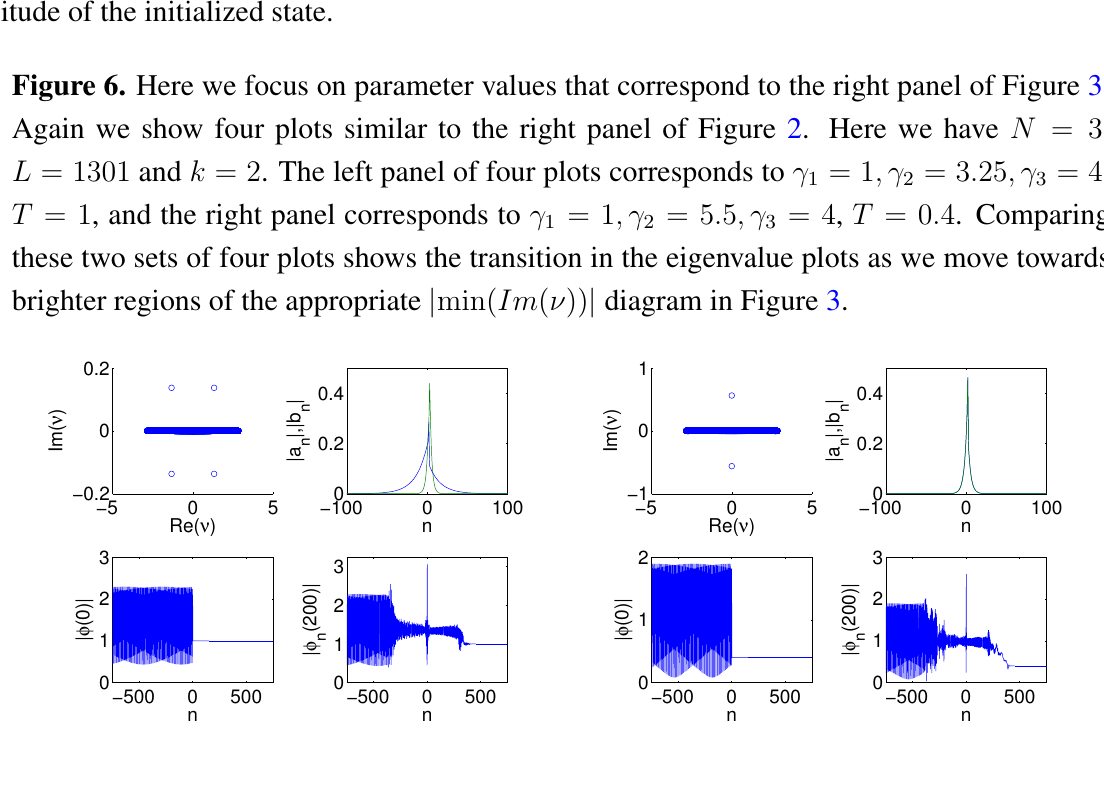
Figure 6. Here we focus on parameter values that correspond to the right panel of Figure 3. Again we show four plots similar to the right panel of Figure 2. Here we have N = 3 ,